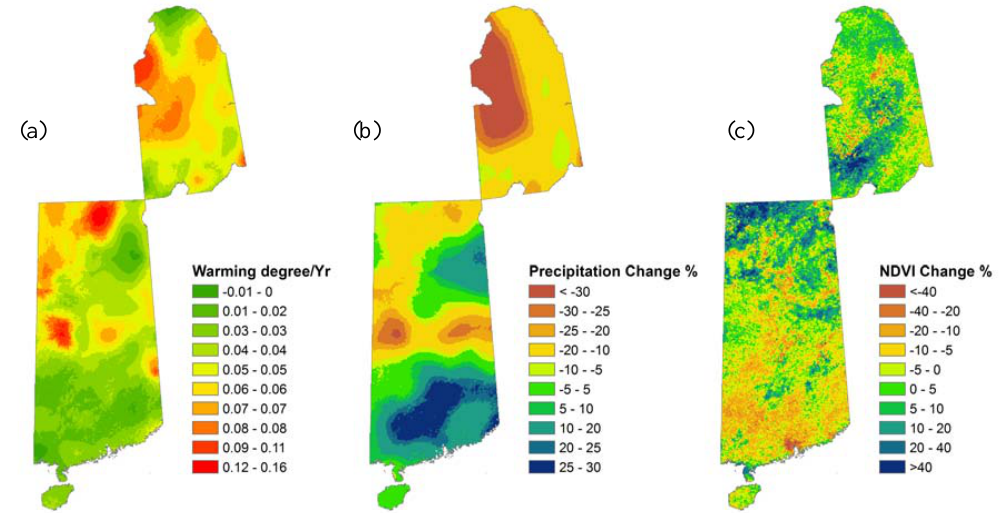
Fig. 3. (a) Averaged change rate (degreeyr − 1 ) of mean growing season temperature (MGT) from 1982 to 2006. (b) Averaged change rate (%) of mean growing season precipitation (MGP) from 1982 to 2006. (c) Averaged change rate (%) of time integrated NDVI for growing season (TI-NDVI g ) from 1982 to